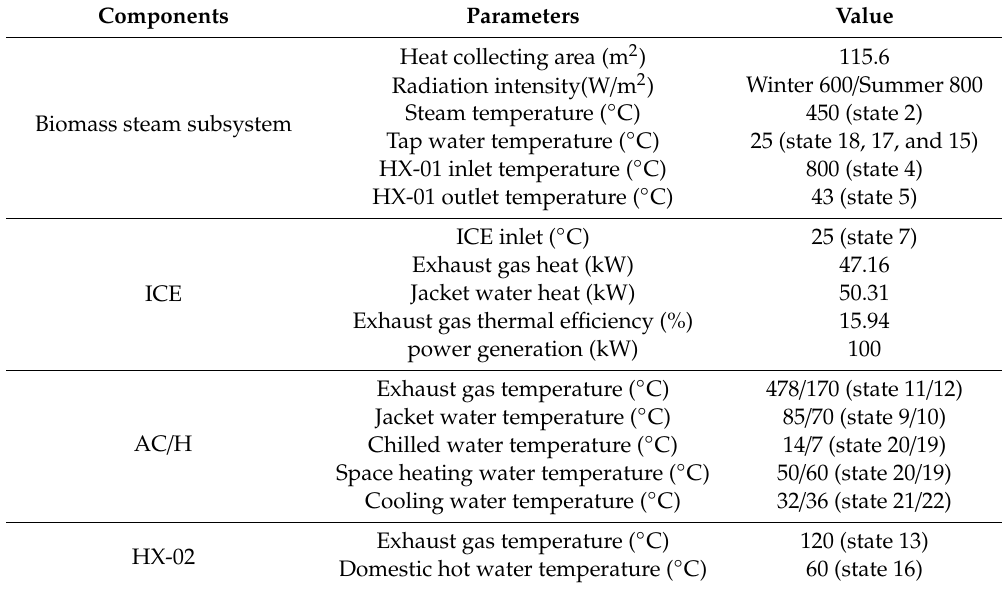
Table 1. Base design